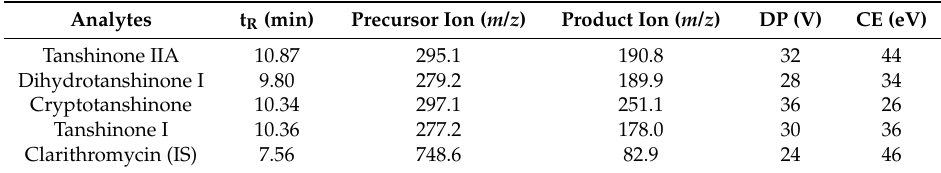
Table 1. The retention time (t R ), optimized MS/MS transitions, declustering potential (DP) and collision energy (CE) for four analytes and IS.